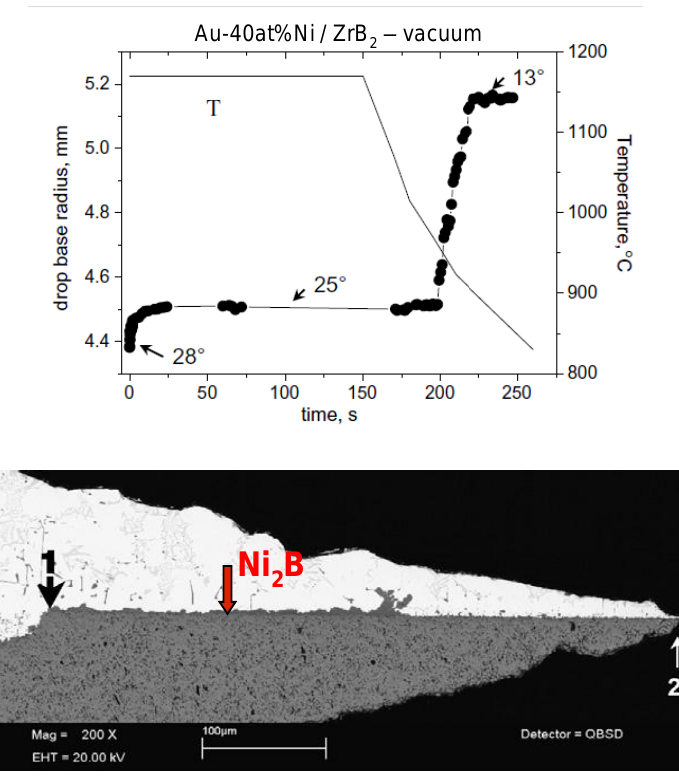
Figure 11. Au-40 at% Ni/ZrB 2 system. Top : Drop base radius and temperature as a function of time. The numbers on the drop base radius curve represent the corresponding values of the contact angle. Bottom : Micrograph of the interface close to the triple line formed during cooling. 1 and 2 indicate the positions of the triple line before and after cooling